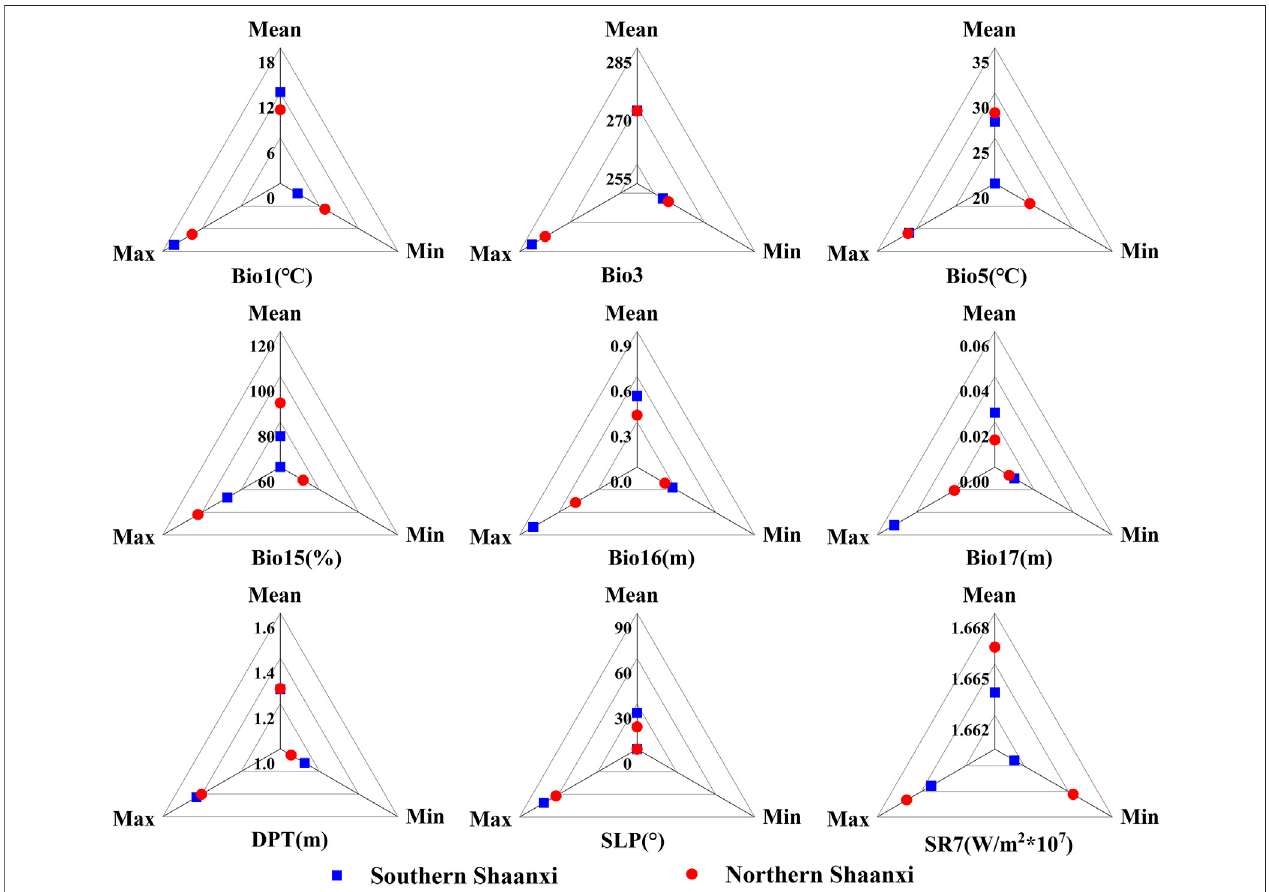
FIGURE 5 | Mean, maximum and minimum values of 9 signi fi cant environment variables in Southern and Northern Shaanxi.